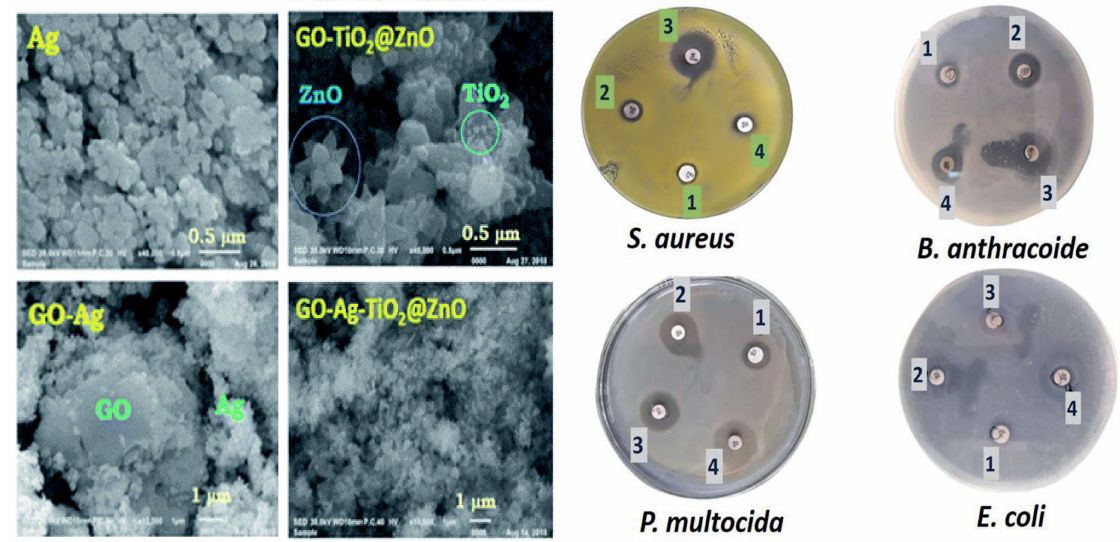
Figure 10. Left : SEM images of Ag, GO–Ag, GO–TiO2@ZnO, and GO–Ag–TiO2@ZnO nanocomposite. Right : Inhibitory zones of GO–Ag–TiO2@ZnO nanocomposite against S. aureus, B. anthracoides and Gram-negative E. coli and P. multocida . Adapted from Ref. [98], with permission from the Royal Society of Chemistry,